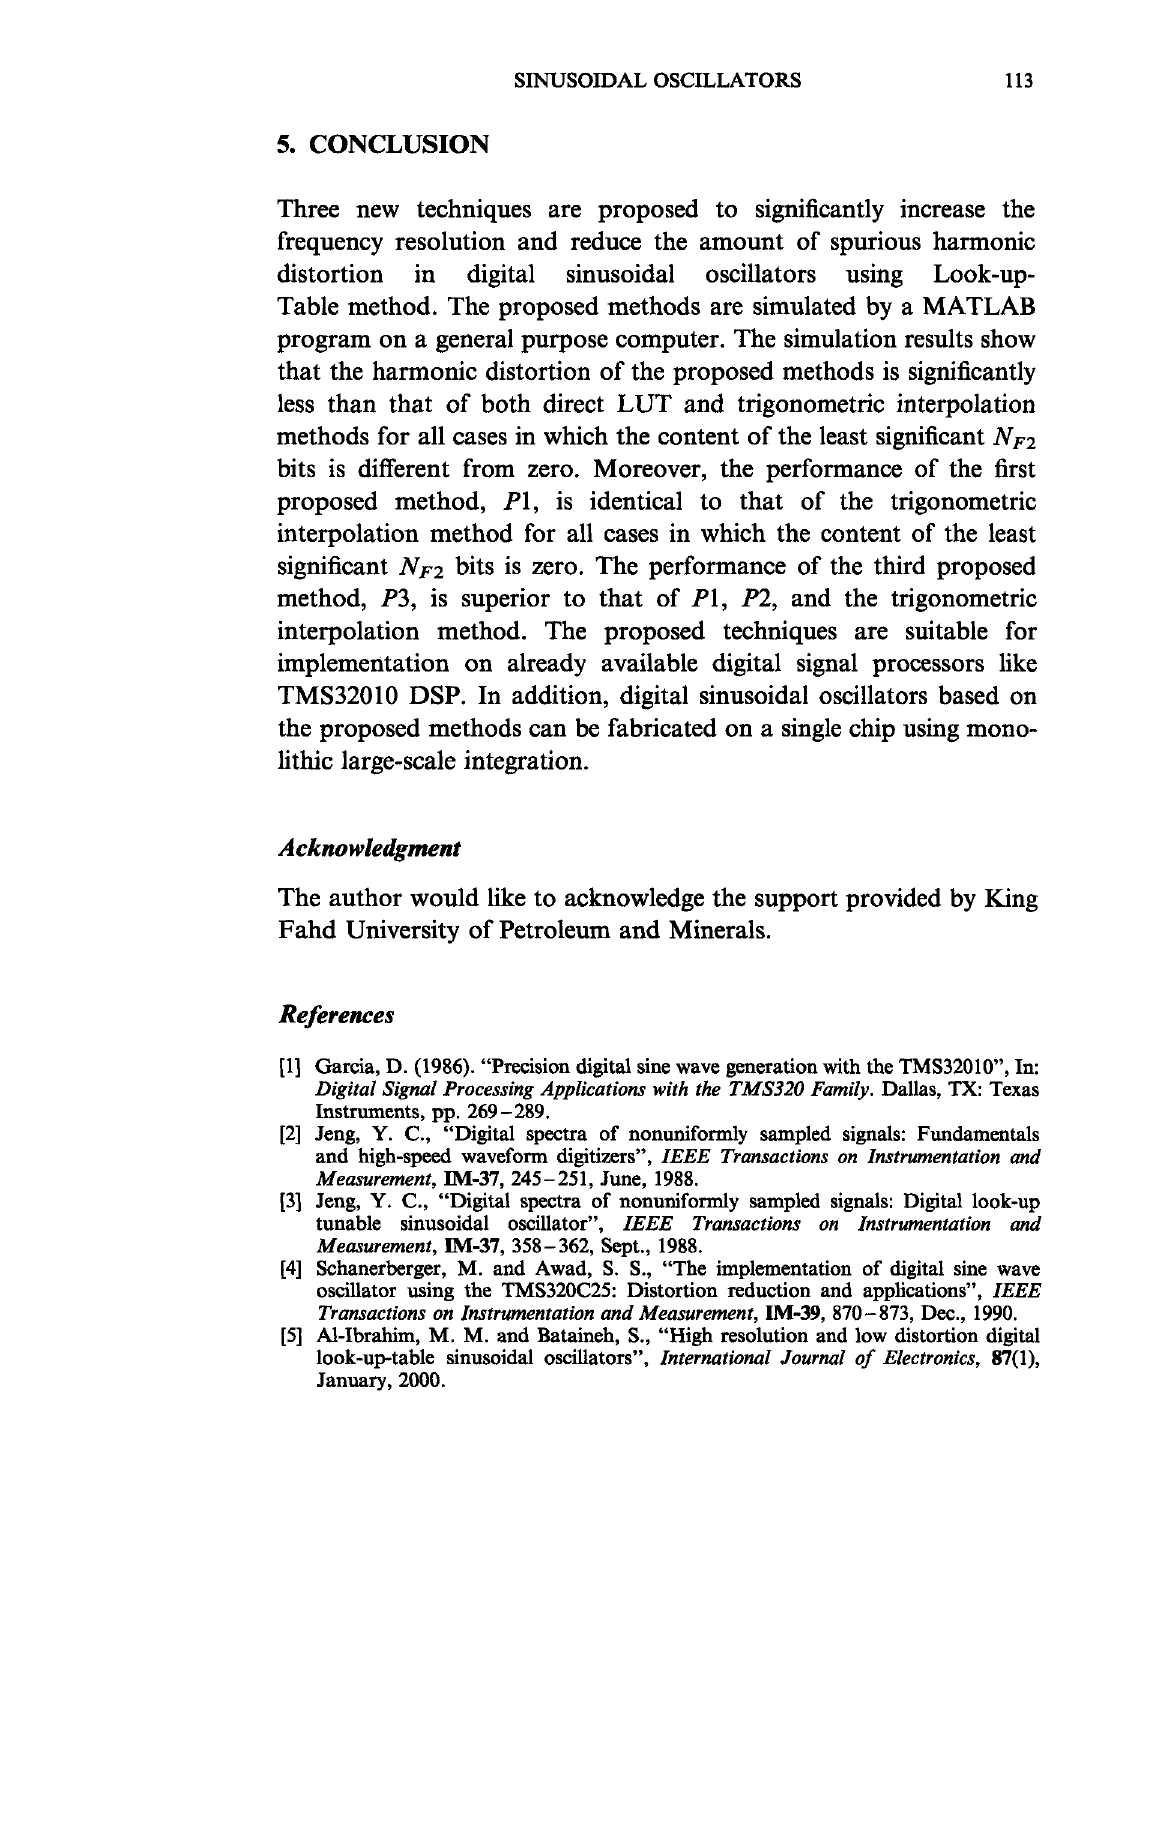
Table method. The proposed methods are simulated by a